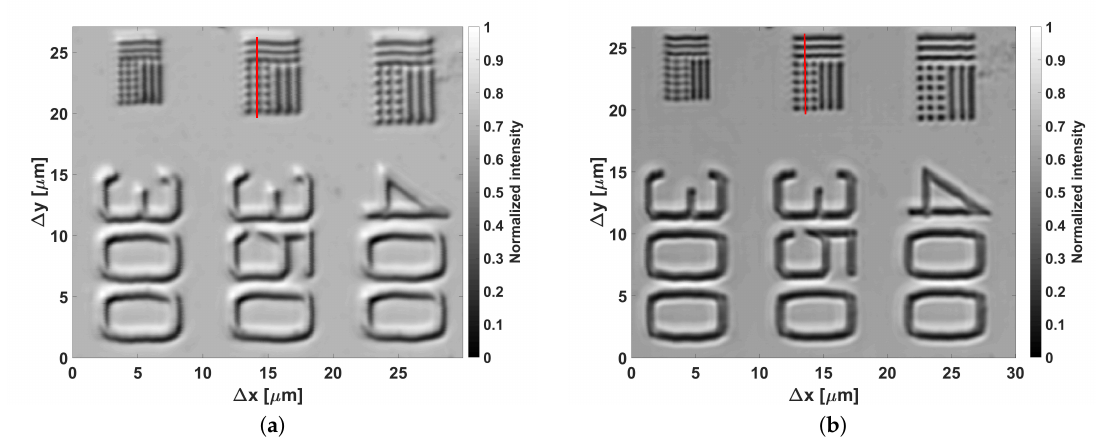
Figure 8. ( a ) In-focus image using a 10 AU pinhole. ( b ) Image with PDM far using a 10 AU pinhole.